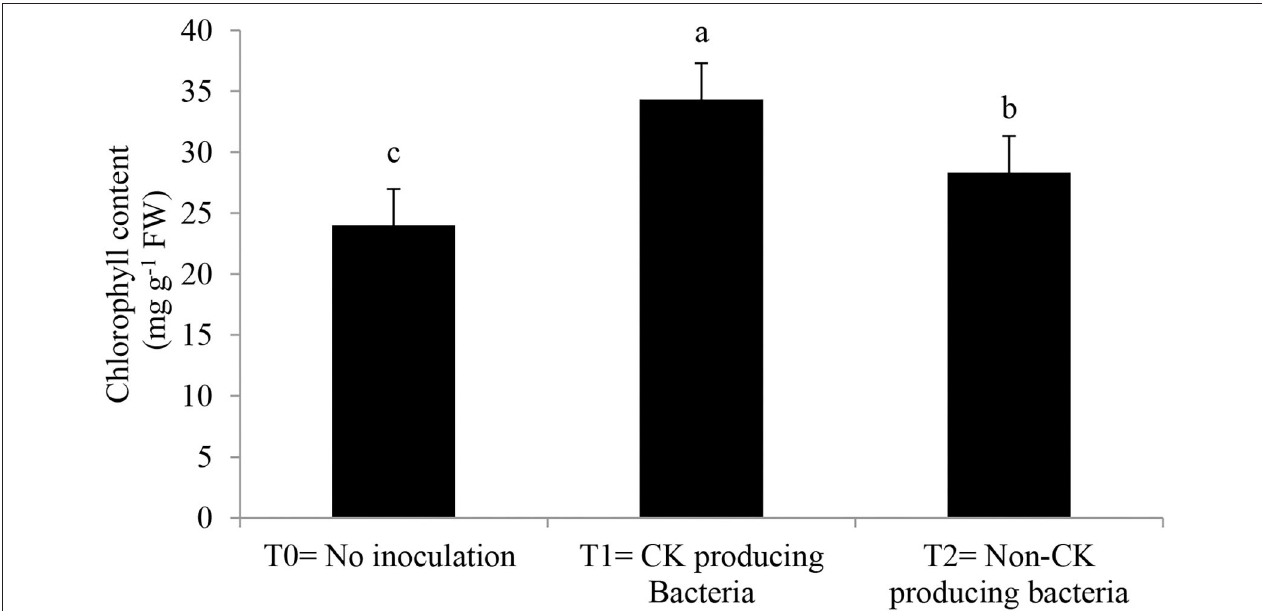
FIGURE 3 | Effect of Ck producing A. brasilense RA − 17 and non-producing A. brasilense RA − 18 on relative chlorophyll content (mg g − 1 FW) of wheat. T0 = no inoculation; T1 = Ck producing strain, and T2 = non-Ck producing bacterial strains. The different letter shows a significant difference in treatments at a 5% probability level.